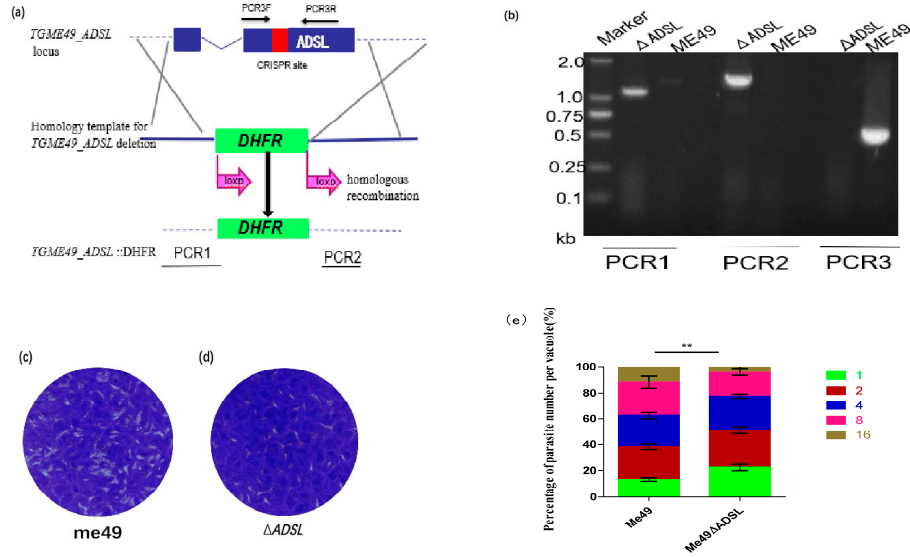
Figure 1. Generation and analysis of an ADSL deletion mutant. ( a ) Schematic illustration of knocking out ADSL in ME49 to produce Δ ADSL . ( b ) Diagnostic polymerase chain reaction (PCR) for a Δ ADSL mutant clone. ( c , d ) Plaque assay comparing the growth of the Δ ADSL mutant to that of the wild-type strain ME49. ( e ) Tachyzoite replication under standard tissue culture conditions. HFF cells were infected with purified tachyzoites, invading parasites were cultured for 24 h, and then fluorescently stained to determine the number of parasites in each parasitophorous vacuole (PV), ** p < 0.01, two-way analysis of variance.